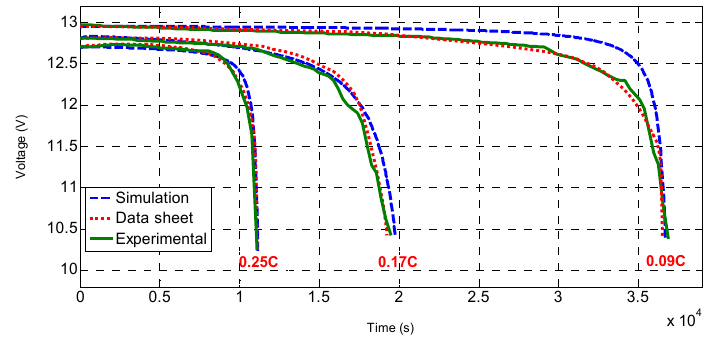
Figure 6. The discharge voltage vs. time at 0.25/0.17 and 0.09 C.